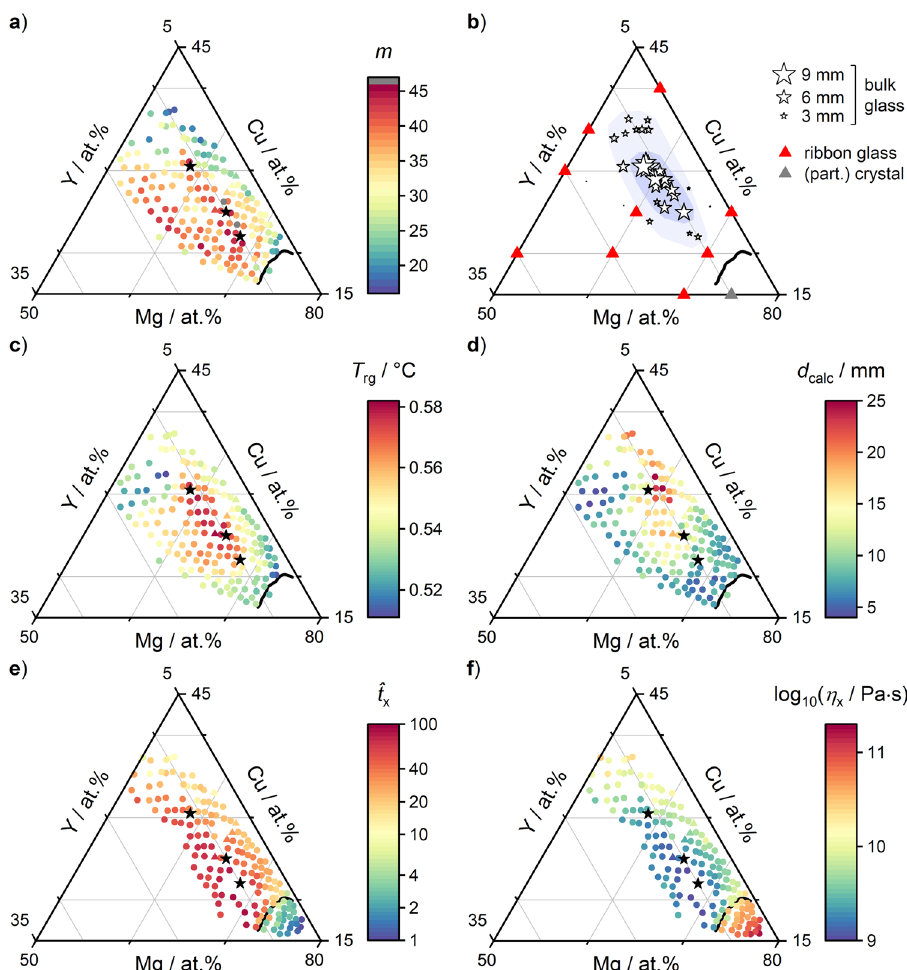
Fig. 4 Composition maps of the fragility and other properties, and comparison to glass forming ability in Mg – Cu – Y. a Variation of fragility m as determined via FIM. b Curated map of glass forming ability (GFA). Bulk glasses with high GFA can be formed in a narrow region along Mg 68 − x Cu 22 + x Y 10 ( x from 0 to 13). GFA rapidly decreases to the sides. (Curated from published bulk and ribbon data, and additional self-prepared suction-cast wedge-type bulk samples. Full data and details in SI.) c The reduced glass transition temperature T rg (Eq. (3)) is calculated using T g data from FIM (Fig. 3a) and literature- based liquidus data (see SI). d Predicted critical casting thickness d calc calculated according to the model by Johnson et al. 18 , which combines m and T rg (Eq. (4)). e ^ t x , the crystallization time in relaxation time units as an indicator of crystallization complexity (Eq. 5). For example, an alloy with ^ t x = 100 requires 100 times the relaxation time to crystallize, which re fl ects the kinetic complexity of the crystallization process. f Viscosity at the crystallization onset η x , which is the lowest viscosity value reached before crystallization. A higher crystallization complexity allows to reach lower η x , even for those compositions which exhibit the highest fragility